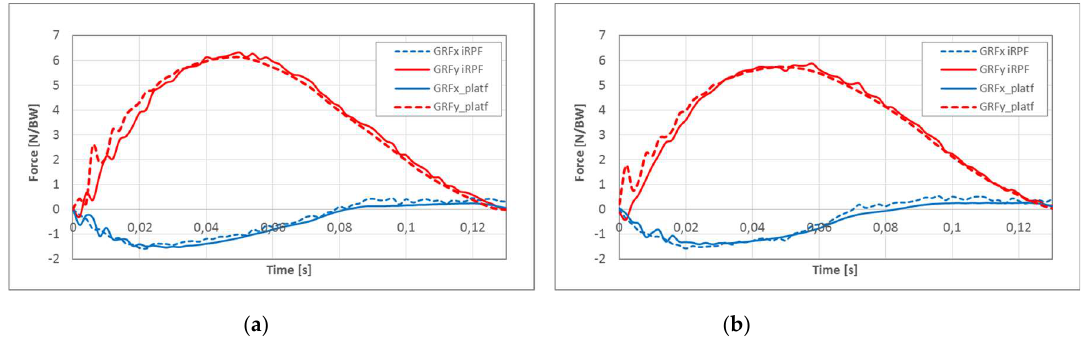
Figure 13. Validation of the Ottobock iRPF, by comparison of GRF measured with the Force Platform and with the iRPF during a long jump test of athlete KD2 loads resolved in the Global reference system: ( a ) validation graph of long jump n ° 21 (speed at the takeoff = 6.45 m/s, length = 4.50 m) and ( b ) validation graph of long jump n ° 22 (speed at the takeoff = 6,.45 m/s, length=4.30 m). The maximum peak value errors and the root mean square error (RMSE) normalized to the peak values for the three dynamic validations set of tests, in horizontal x and vertical y in the GRS directions are collected in Table 2.